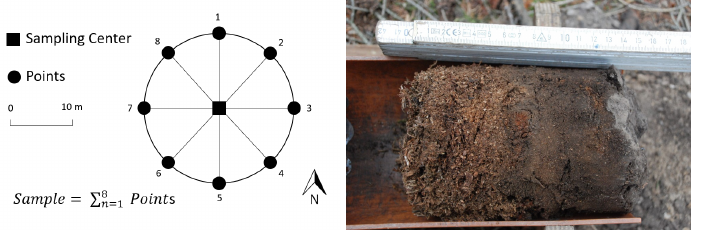
Figure 2. Schematic presentation of the sampling design ( left ) and humus sample during data collection ( right ).